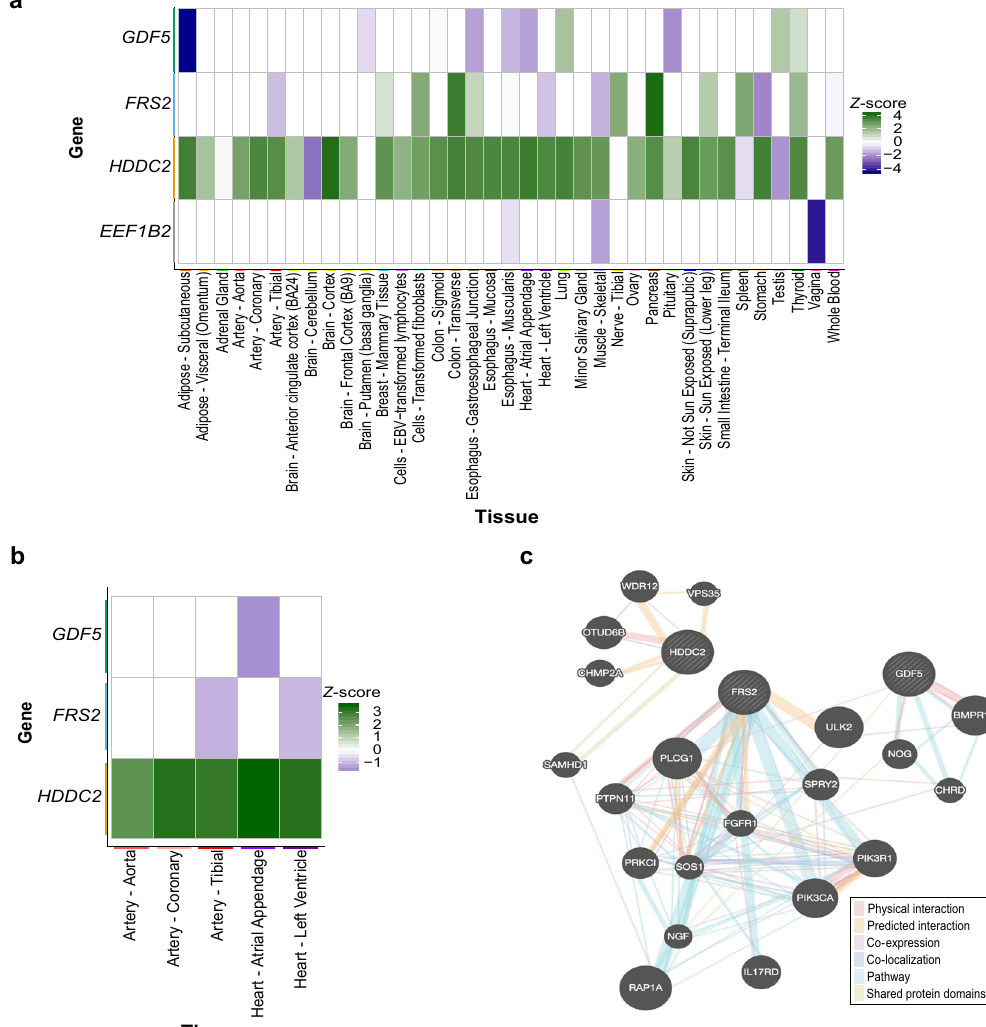
Fig. 2 ACT TWAS identi fi es novel candidate genes based on expression pro fi les. a Analysis of diverse tissues identi fi ed four genes that passed an FDR correction for multiple testing in the TWAS and indicate that expression may modify ACT risk. Gene-level Z -scores, re fl ecting the number of standard deviations the mean expression of the gene (adjusted for the weight of each eQTL in fl uencing expression of the gene) in ACT cases is from that of controls, across tissues where these genes were detected are plotted. b Association of top TWAS associated genes in tissues most relevant for ACT (i.e. heart and arterial). Z -score > 0 (green) indicates increased expression in ACT cases, while Z -score < 0 (purple) indicates decreased expression in these patients. c Gene interaction networks for the top TWAS associated genes identi fi ed using GeneMANIA.